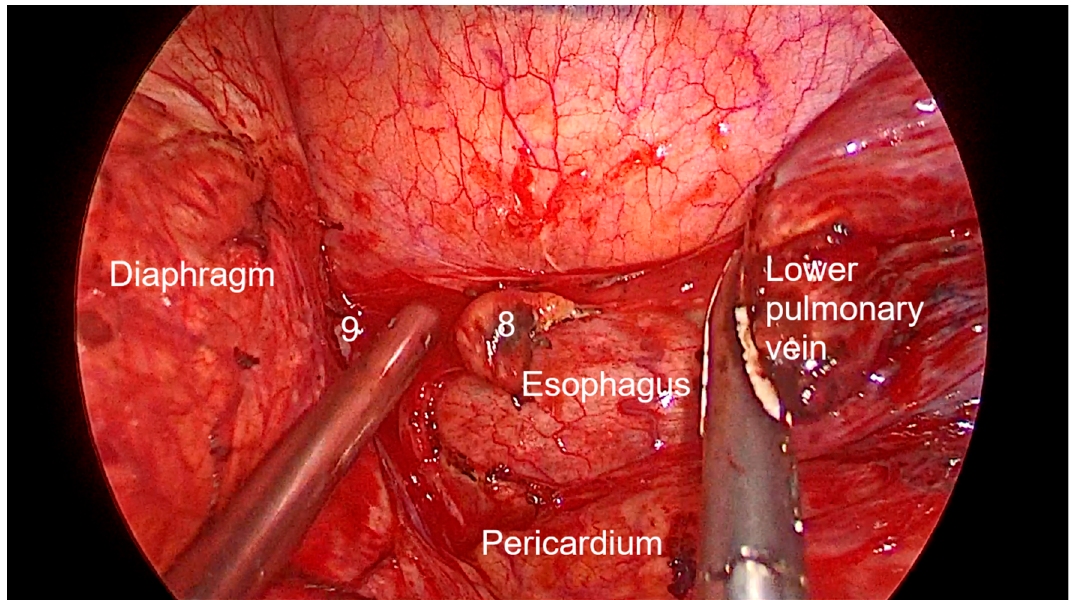
Figure 7. Anatomic landmarks during right paraoesophageal (8) and pulmonary ligament (9) lymph node dissection.